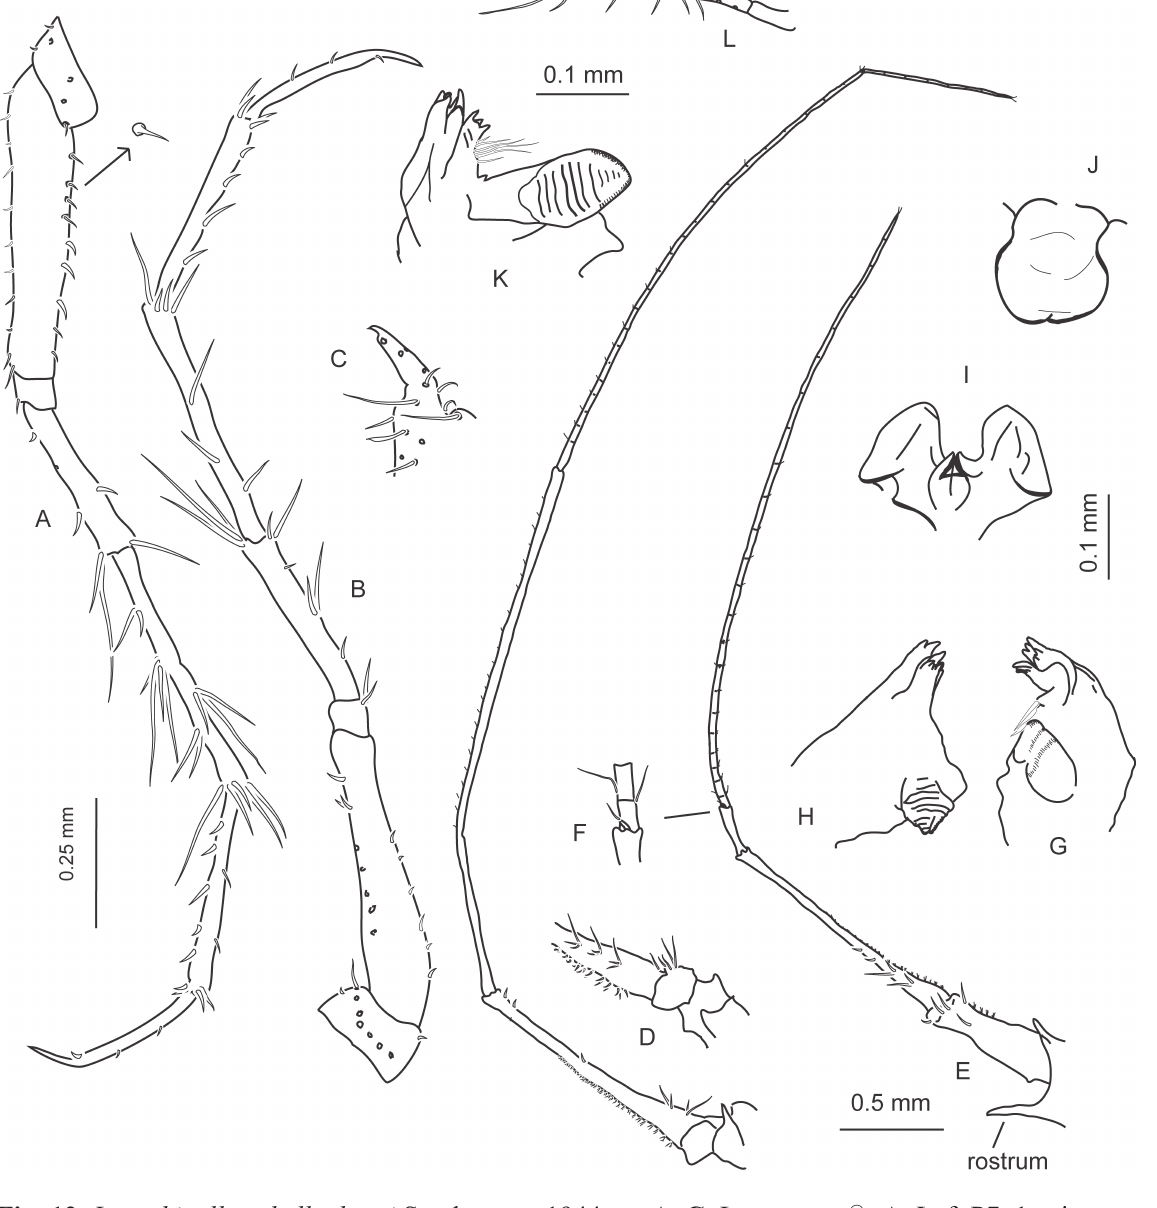
Fig. 12. Lepechinella schellenbergi Stephensen, 1944 . — A–C . Lectotype, ♀. A . Left P7, 1 spine on basis is enlarged. B . Left P6. C . Tooth of peraeon segment 6. — D–J . Paralectotype 1, ♂. D . Left and right male A2. E–F . Male A1 with accessory flagellum. G–H . Right and left mandible. I . Lower lip. J . Upper lip. — K–L . Paralectotype 2, ♀, mandible and mandible